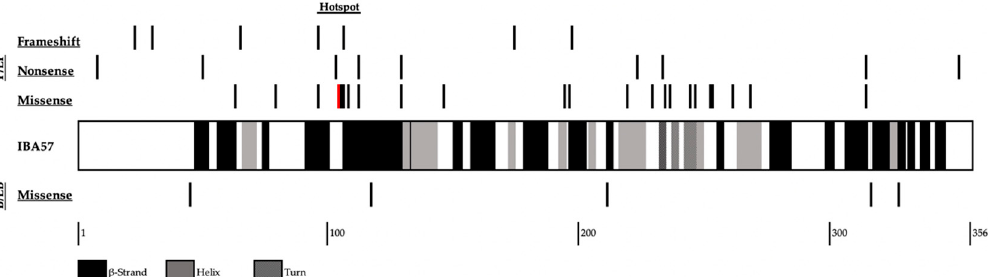
across all reported IBA57 homologs.